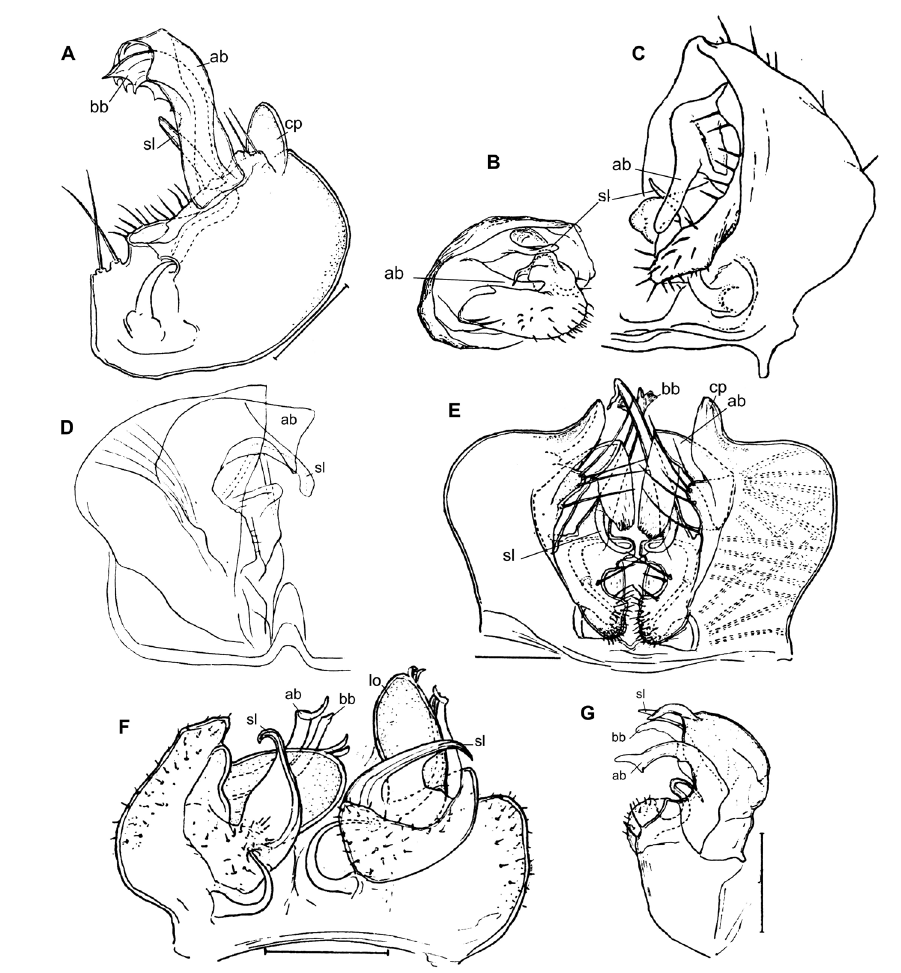
Figure 2. Gonopods of the type species of some African Trichopolydesmidae. A Heterosphaeroparia- villiersi Schubart, 1955 (after Schubart 1955) B, C Mecistoparia lophotocrania Brolemann, 1926 (after Brolemann 1926) D Dendrobrachypus pusillus Verhoeff, 1941 (after Verhoeff 1941) E Eburodesmus erectus Schubart, 1955 (after Schubart 1955) F, G Hemisphaeroparia cumbula Schubart, 1955 (after Schubart 1955). Reproduced not to scale. Abbreviations: ab apical branch of telopodite, bb basal branch of telopo- dite, cp coxal process, lo lobe, sl